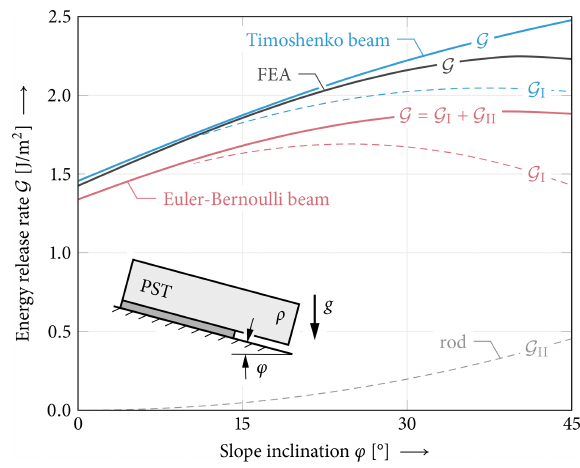
Figure 9. Total, mode I and mode II energy release rates in prop- agation saw tests of different slope angles ϕ with crack length a = 30cm. Comparison of the present model using Timoshenko beam kinematics accounting for shear deformation of the slab and the classical Euler–Bernoulli beam model. The latter is recovered in the limit case of infinite shear stiffness of the beam ( κGA → ∞ ). Model parameters other than E weak = 0 . 15MPa and t = 5cm are chosen as given in Fig. 1.